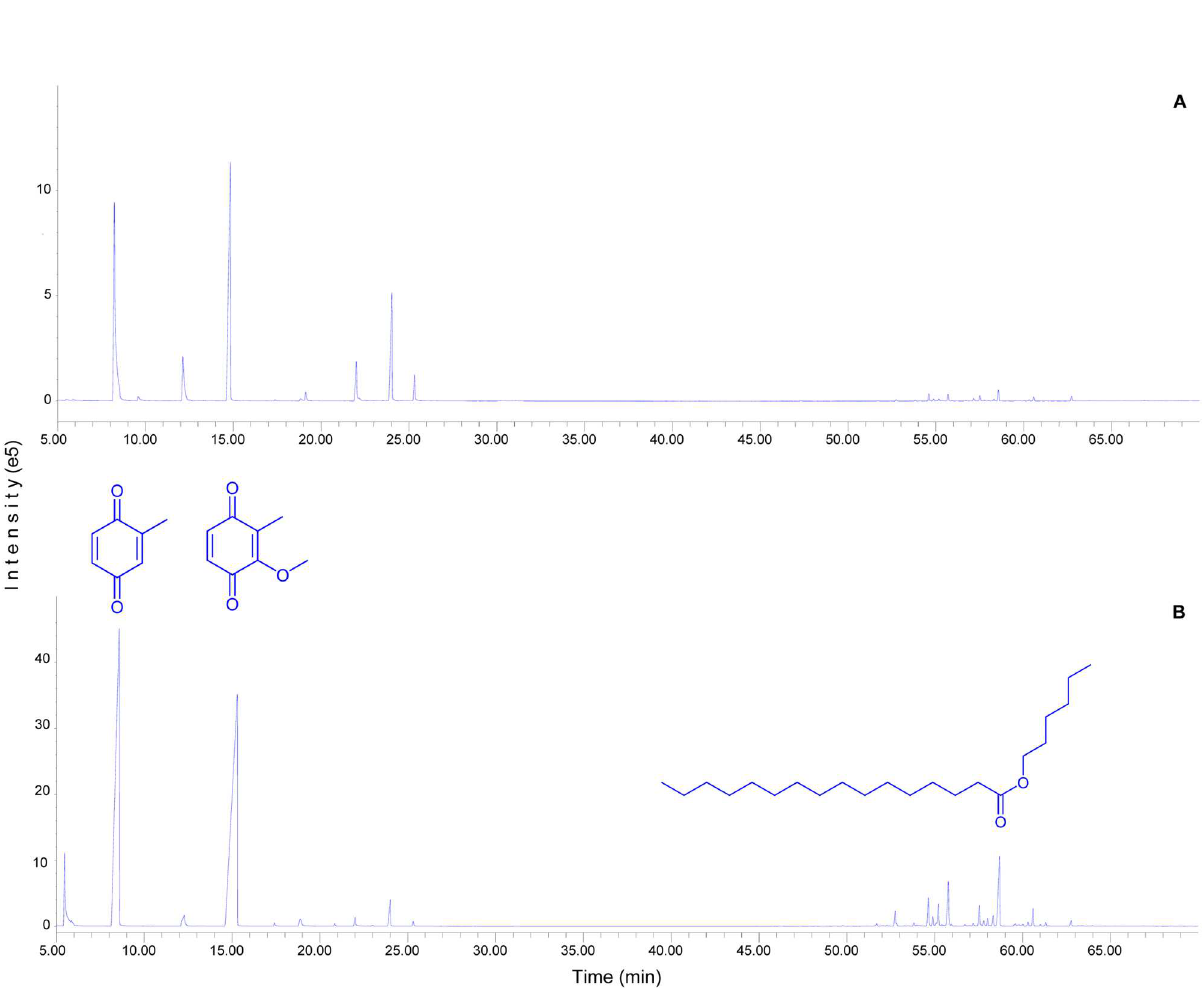
Fig 1. GC-FID profiles of A) male and B) female secretions of the millipede Pachyiulus hungaricus (Karsch, 1881) with chemical structure of most dominant quinone and non quinone